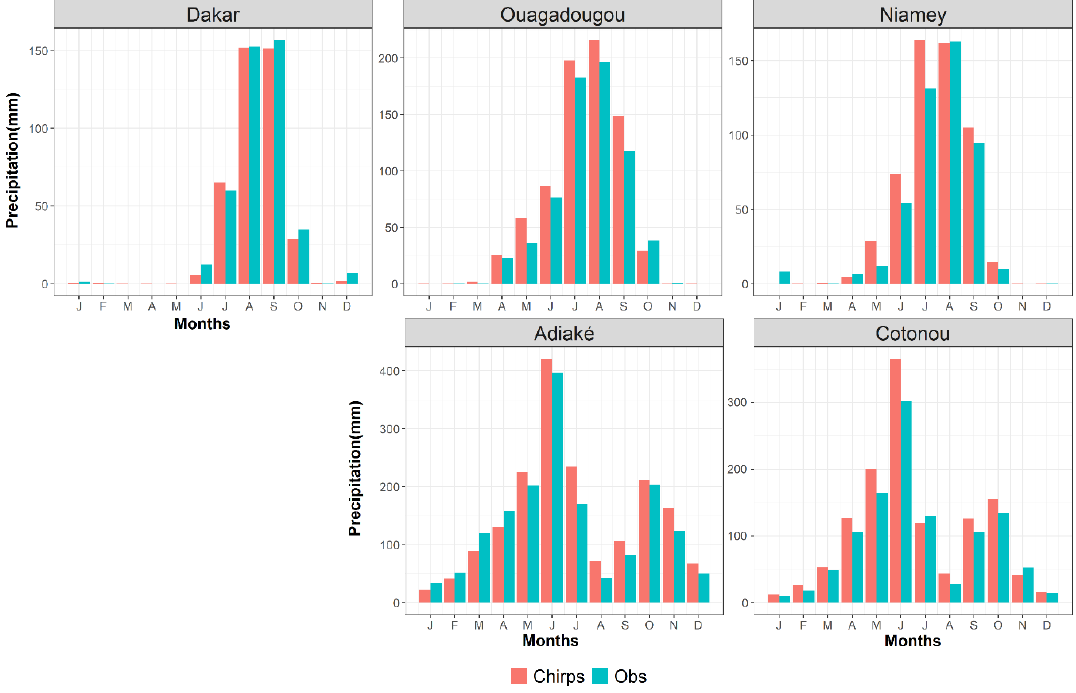
Figure 3. Comparison of the monthly mean rain gauge stations and the corresponding nearest grid points in the CHIRPS dataset for the considered five stations.